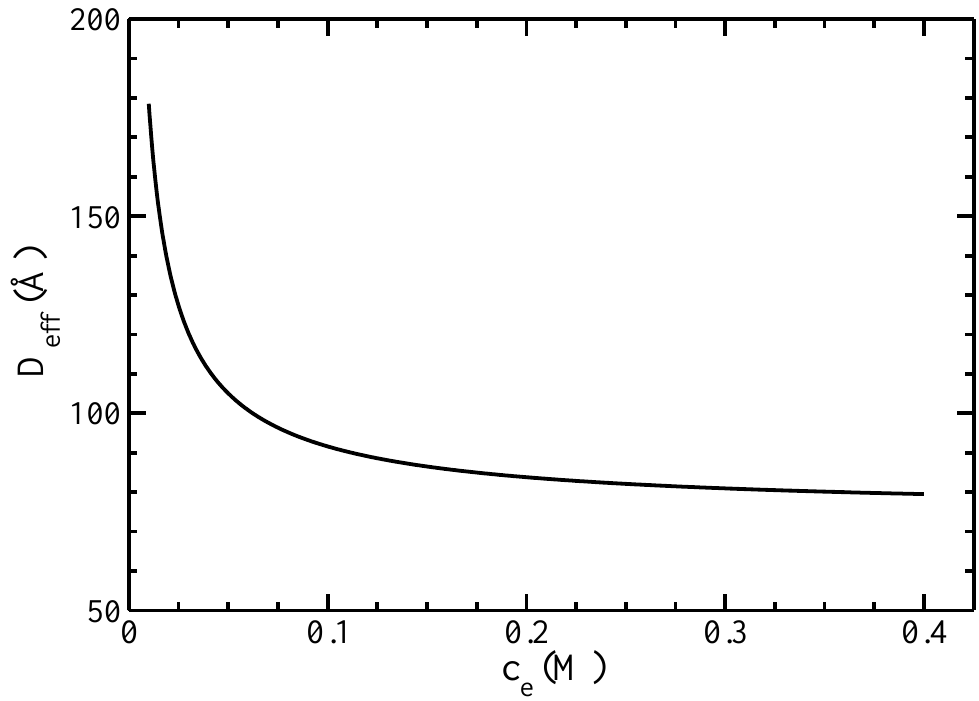
Figure 10. The effective diameter D ef f as a function of the monovalent ions’ concentration c e